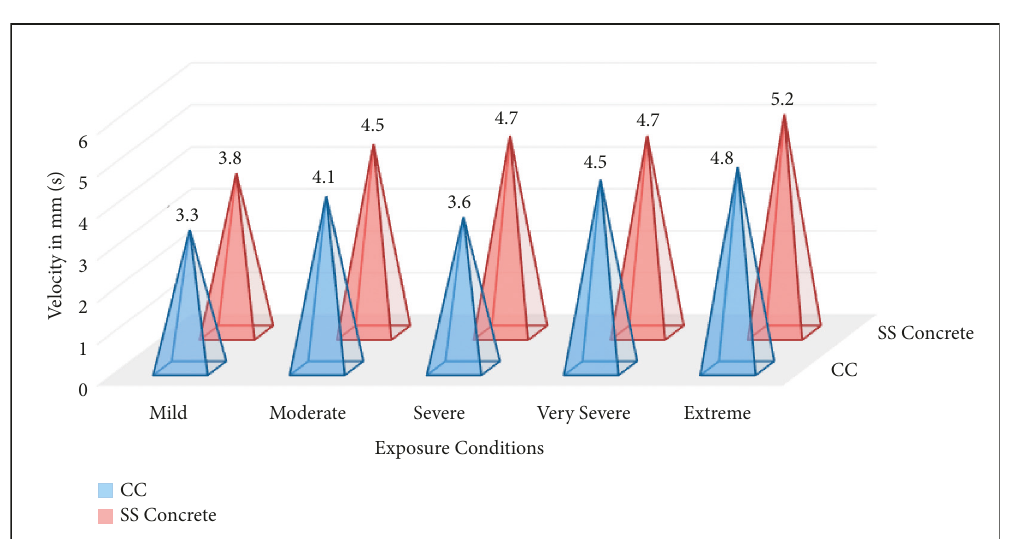
Figure 8: UPV of CC and steel slag concrete for different exposure